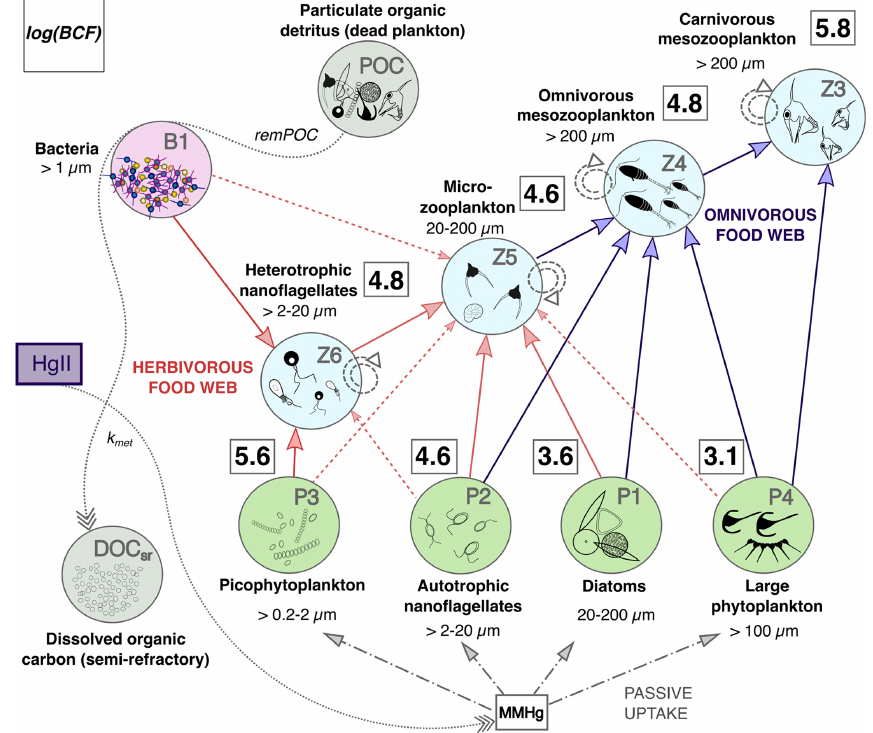
Figure 8. Conceptual model of MMHg bioaccumulation in the plankton food web of the OGSTM–BFM–Hg model, subdivided into a lower “herbivorous” (red arrows) and upper “omnivorous” (blue arrows) food webs. The squares with bold numbers show estimated values of the bioconcentration factors (log(BCF)) for each PFT, calculated for the Sad subbasin from spatially averaged model output at monthly resolution. The green circles indicate the four phytoplankton PFTs (P1, P2, P3, and P4, representative respectively of diatoms, autotrophic nanoflagellates, picophytoplankton, and large phytoplankton), the light blue circles indicate the four zooplankton PFTs (Z3, Z4, Z5, and Z6, representative respectively of carnivorous mesozooplankton, omnivorous mesozooplankton, microzooplankton, and heterotrophic nanoflag- ellates), the purple circle indicates bacteria (B1, representative of all heterotrophic bacteria), and the grey circles indicate particulate organic carbon (POC, representative of all organic detritus) and semi-refractory dissolved organic matter (DOC sr ). The solid arrows show the pref- erential trophic interactions, the dashed arrows are for secondary trophic interactions (diet switch if the favorite preys are not available), and the circle dashed arrows are for cannibalization within the same zooplankton group. The dash and dotted arrows indicate passive uptake of MMHg by phytoplankton. The dotted arrows indicate the processes of transformation related to carbon recycling by bacteria (remPOC) and of Hg methylation, whose kinetics are coupled through the parameter k met , converting Hg II into